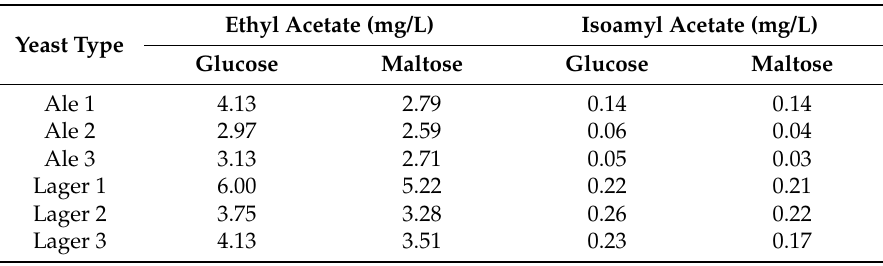
Table 3. Ethyl acetate and isoamyl acetate produced by brewing yeast strains during fermentation of synthetic media [12] a